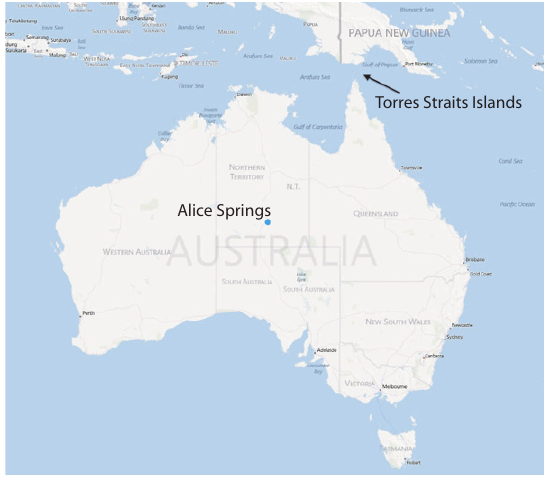
Figure 1. Map of Australia showing location of Alice Springs in the Northern Territories and Torres Strait Islands.